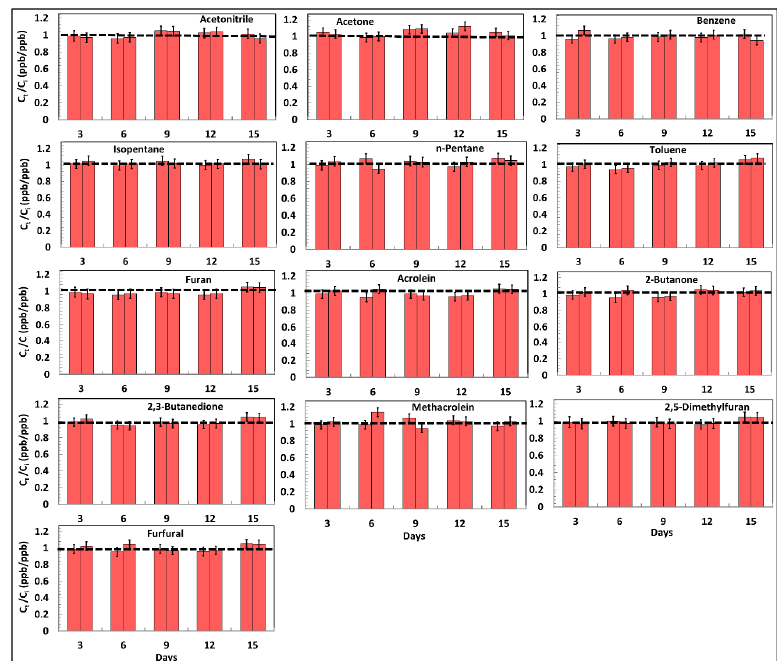
Figure 3. Stability of VOCs over the storage of 15 days inside the dual-bed Carboxen-Graphsphere TD tubes sampled using calibration gas. Histograms in each VOC plot correspond to the ratio of VOC concentration measured after “t” days of storage (C t (ppb)) relative to the initial concentration on day 0 (C i (ppb)). Error bars on each histogram correspond to 1 σ precision from the two TD tubes analyzed